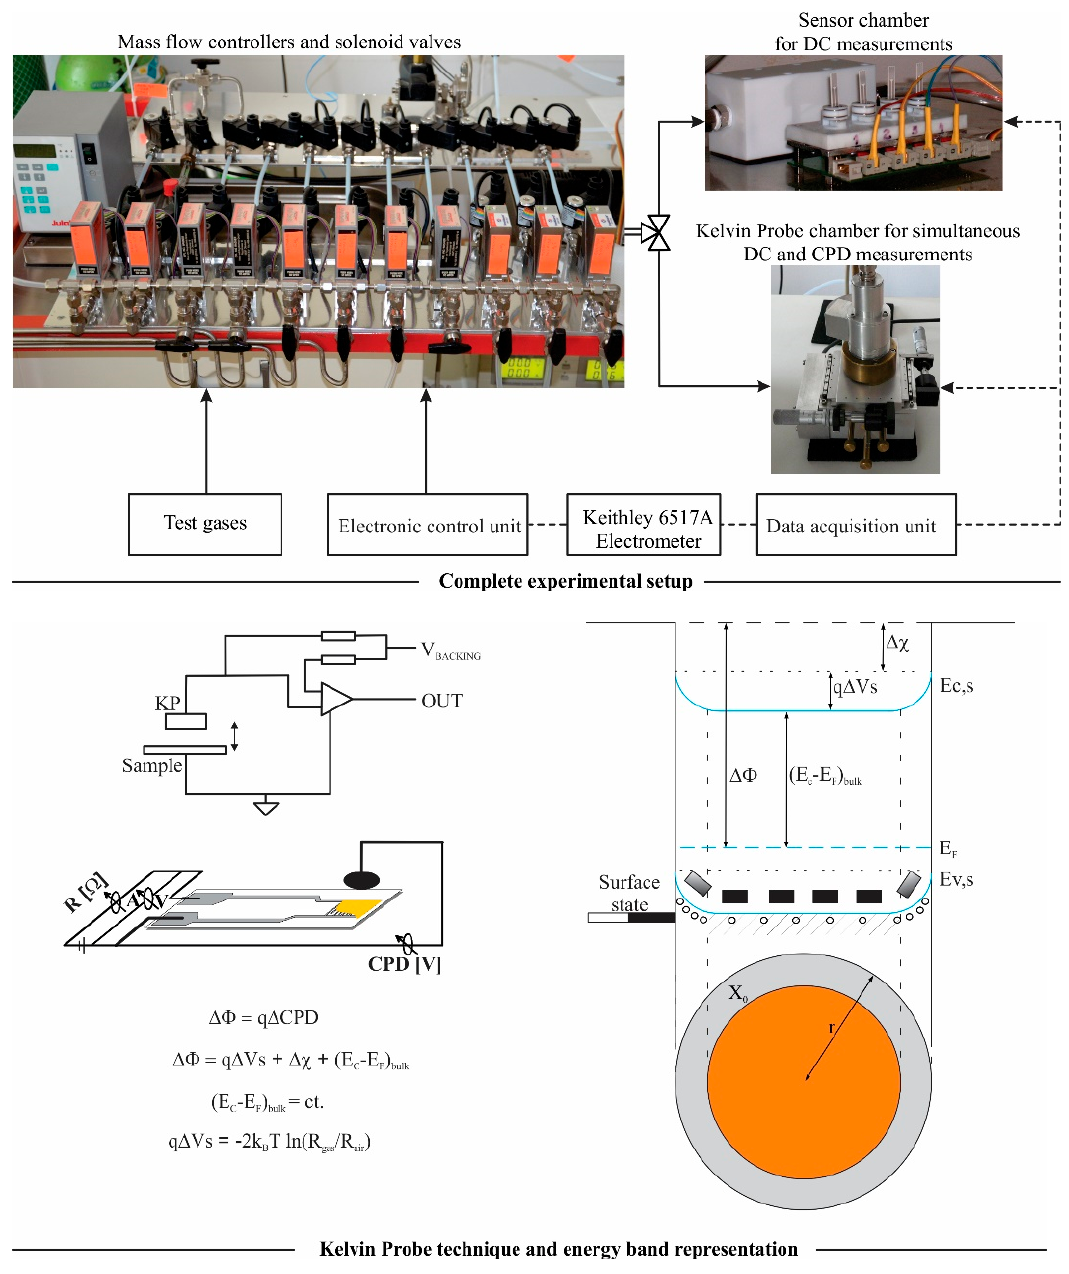
Figure 1. Comprehensive view of the experimental setup on the top part of the image and details of the Kelvin Probe technique involved in the phenomenological investigations on the bottom part of the image.